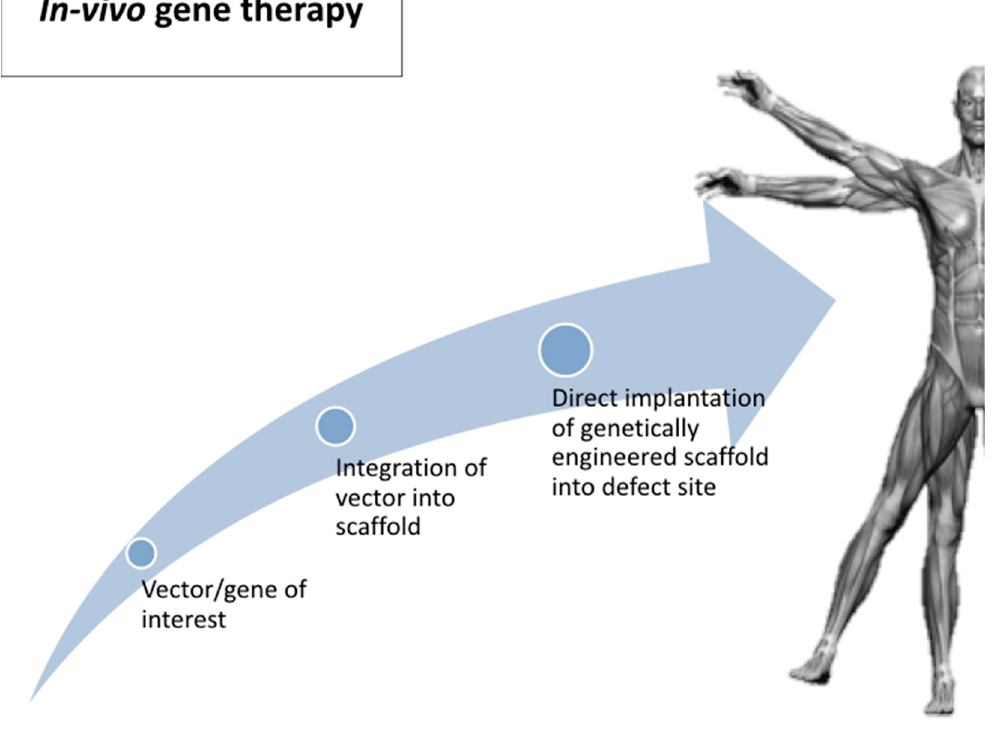
Figure 1. In vivo gene delivery.